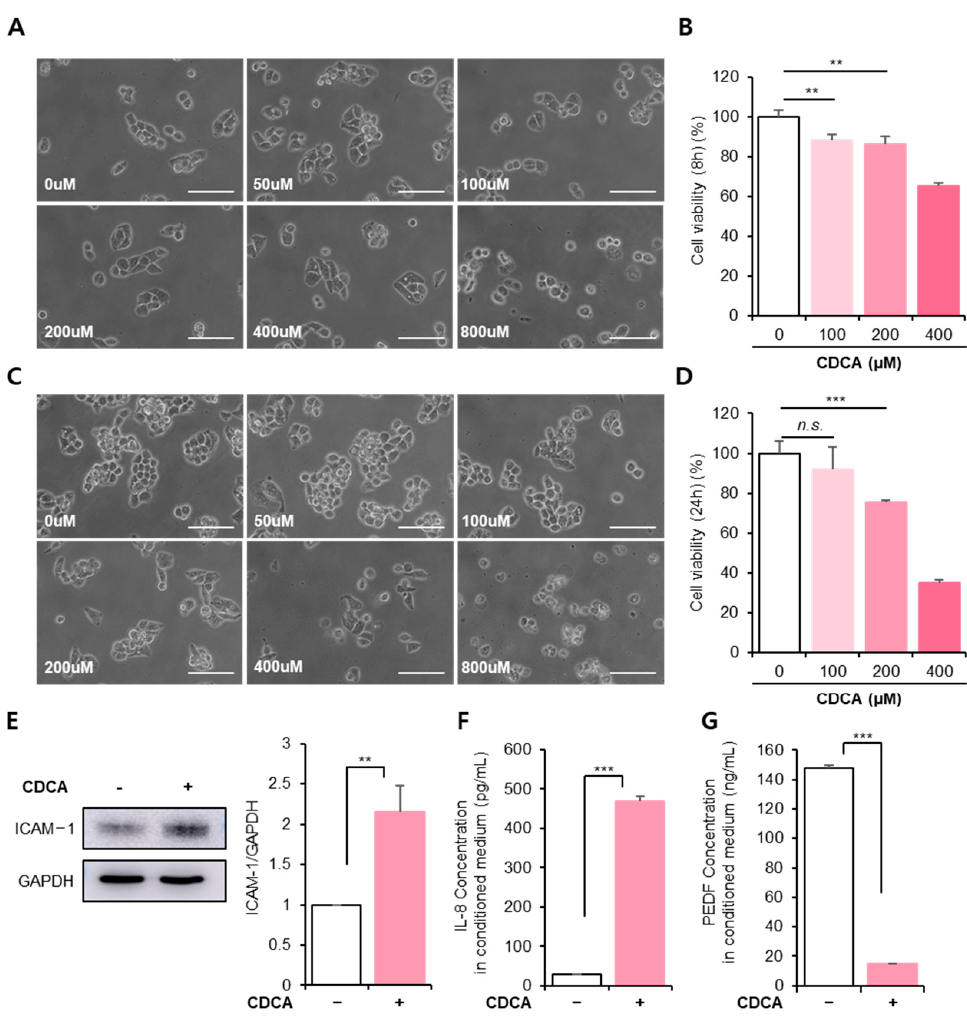
Figure 1. Chenodeoxycholic acid (CDCA) reduces cellular activity and induces inflammatory features in hepatocytes. CDCA effect on hepatocytes was analyzed. HepG2 cells were exposed to various concentrations of CDCA, and cell morphology and viability were evaluated 8 h ( A , B ) and 24 h ( C , D ) after CDCA treatment. Scale bar: 100 µ m. Cell viability was determined using the WST-1 assay and represented relative to the control group. ( E ) ICAM-1 expression was analyzed via Western blotting at 8 h after 200 µ M CDCA treatment and quantified relative to GAPDH using the Image J software. ( F , G ) The conditioned medium of HepG2 cells with CDCA for 8 h was collected and then analyzed for the production of interleukin (IL)-8 ( F ) and pigment epithelium-derived factor ( G ) via enzyme-linked immunosorbent assay (ELISA). The values represent the means ± standard deviations of three independent experiments. ** p < 0.01,*** p < 0.001, n.s : non significant.